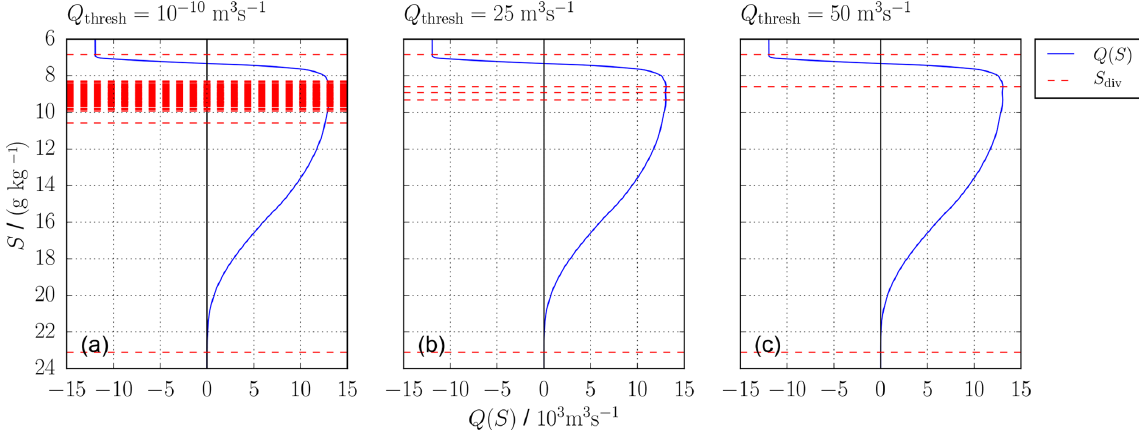
Figure B1. Comparison of the algorithm for (a) Q thresh = 10 − 10 m 3 s − 1 , (b) Q thresh = 25m 3 s − 1 and (c) Q thresh = 50m 3 s − 1 for the Darss Sill data with N = 4096. The number of dividing salinities decreases with increasing threshold